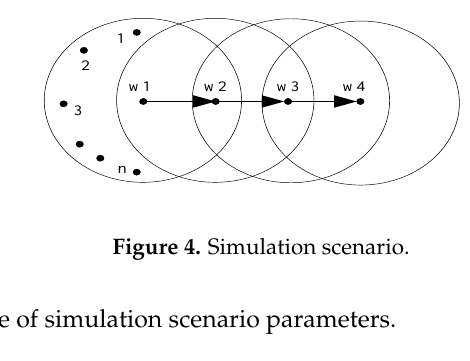
Table 1. Simulation scenario parameter setting. prop refers to the propagation model. Mac refers to the MAC protocol. Ifq refers to interface queue. Ifqlen refers to the length of the interface queue. SIFS refers to the Short Interframe Space. The Phy header refers to the length of the Physical layer header. The Mac header refers to the length of the media access layer header.